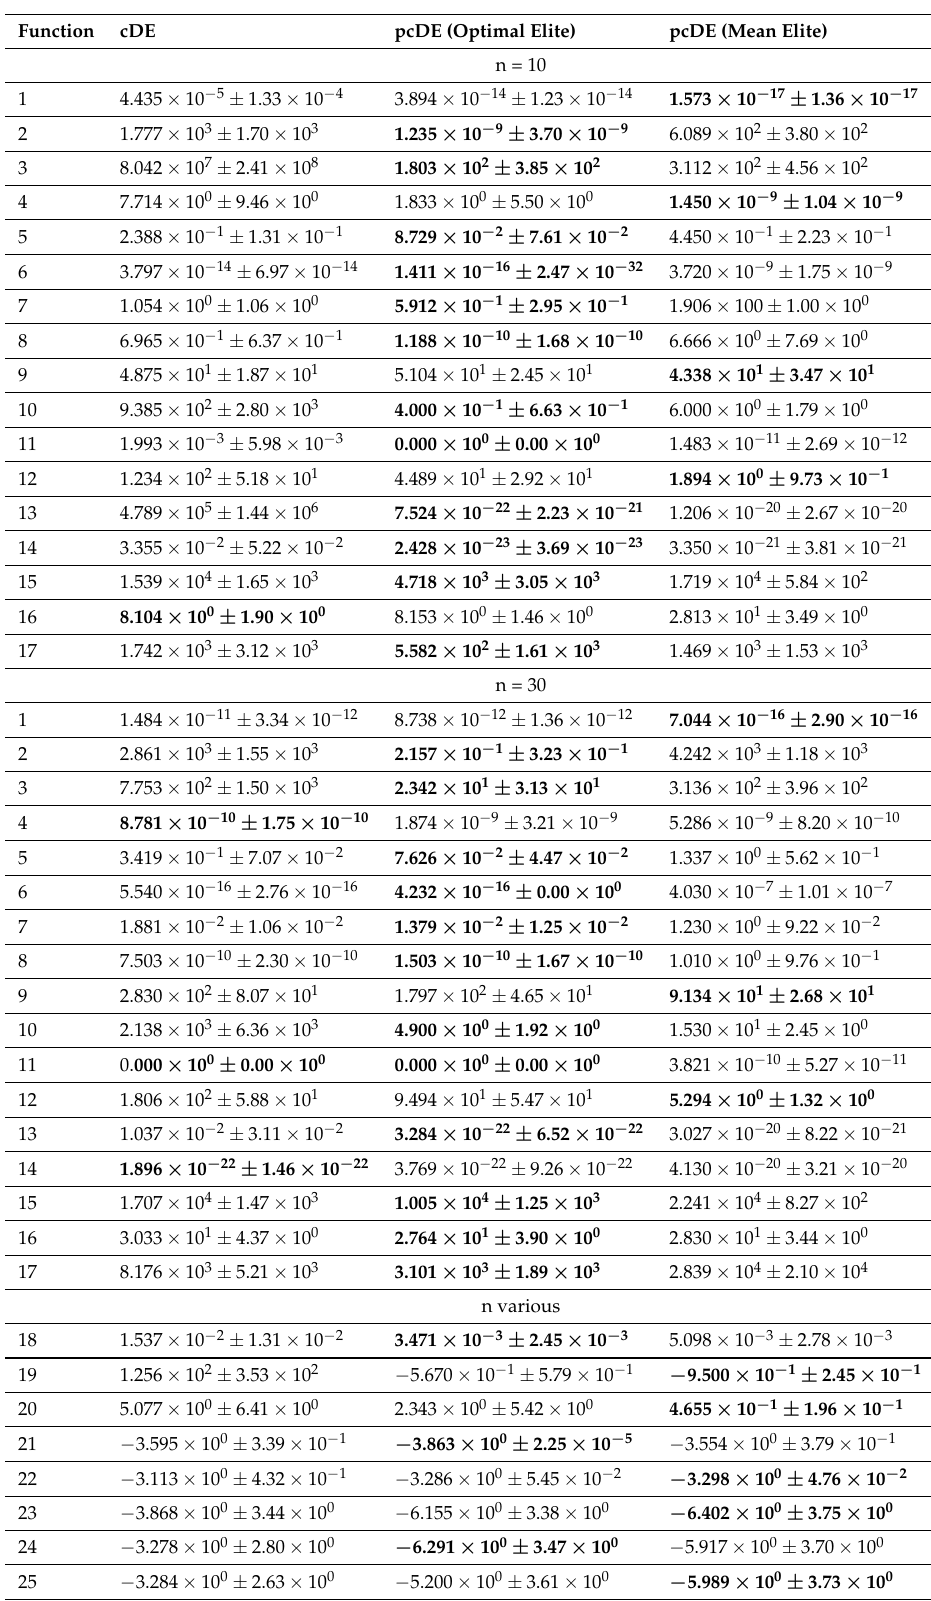
Table 2. Final average fitness ± standard deviation (non-persistent